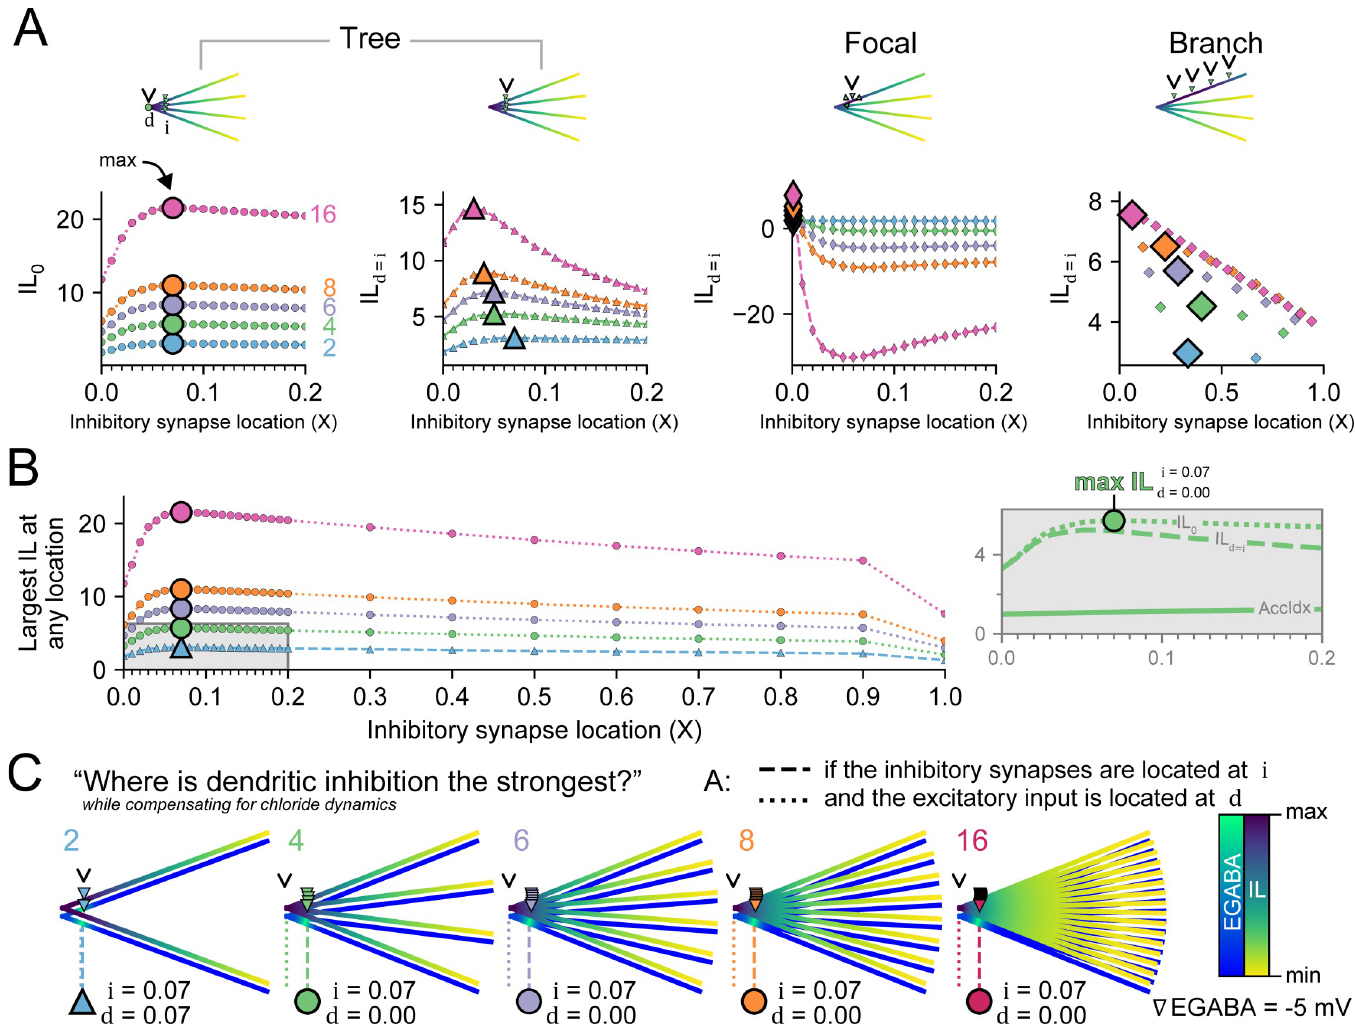
Fig 7. The optimal placement of inhibitory synapses to maximise the suppression of dendritic excitability. Given the same number of inhibitory synapses as dendritic branches we determined their optimal placement for different distribution strategies. (A) Left plots, for the “Tree” distribution (where each branch has a single inhibitory synapse at location i, example inset), the IL was measured (d) at the junction (IL 0 ) and at the inhibitory synapses themselves (IL d = i ). Due to Cl - loading, the maximum IL at the junction (IL 0 ), large marker, occurs when inhibitory synapses are a short distance away from the junction (0.07 X). In constrast, dendrites with more branches generate maximum IL d = i when the inhibitory synapses are located closer to the junction (0.03 to 0.07 X) as more branches mean that there are more avenues for diffusion to ameliorate deleterious [Cl - ] i loading. Second from right plot, Inhibitory synapses placed in the “Focal” distribution (all concentrated at one spot) result in substantial Cl - loading over 500 ms and therefore have an excitatory effect (IL < 0). Right plot, IL d = i for each inhibitory synapse in “Branch” distributions where inhibitory synapses are placed with even spacing along a single branch. (B) The overall largest IL at any location on the dendritic tree is plotted for all varied synapse locations using the “Tree” distribution. The optimal location for inhibitory synapses to create the largest depression of dendritic excitability is � 0.07 X and encircling a junction. For 2 branches (blue), the overall maximum IL is at i itself; but additional branches have their maximum IL at the junction (IL 0 ). This location optimises the cumulative voltage-conductance inhibitory effect of the inhibitory synapses while reducing the pooling of Cl - loading via the synapses themselves. Inset, a dendrite with 4 branches and 4 synapses had its maximum IL when the inhibitory synapses were placed at 0.07 X and IL was measured at the junction (IL 0 ). The IL d = i and the accumulation index (AccIdx = IL 0 / IL d = i ) are also shown for comparison. (C) EGABA and IL heatmaps with the optimal inhibitory synaptic placements (downward triangles) and the location for dampening dendritic excitability the most (arrowhead) for 2 (blue), 4 (green), 6 (purple), 8 (orange), and 16 (magenta) inhibitory synapses and